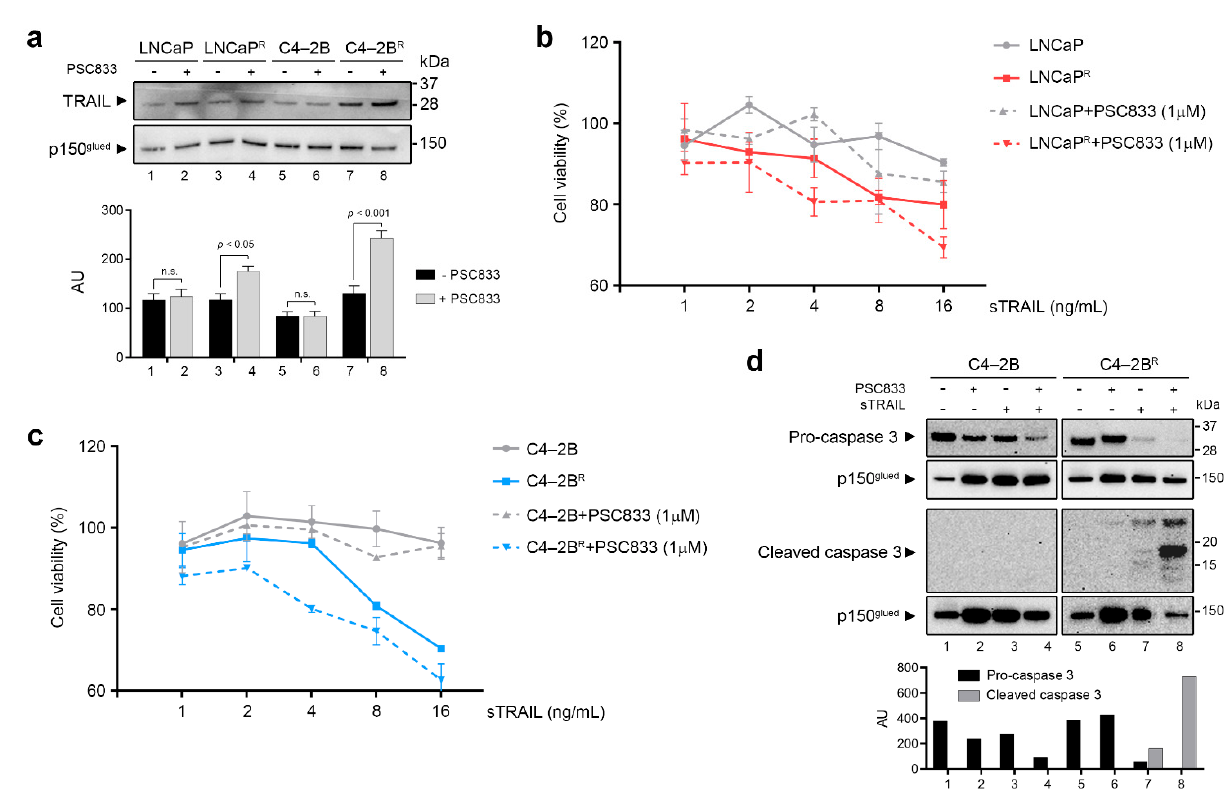
Figure 6. TRAIL status and its role in docetaxel-resistant prostate cancer (PCa) cell lines ( a ) Parental and resistant cells were cultured in the presence or absence of the ABCB1 inhibitor PSC833 for 48 h and total cellular protein extracts were used to assess endogenous TRAIL expression by Western blot. Full Western blot image can be found in Figure S2. Upper panel: representative immunoblot showing levels of TRAIL protein present in whole cell extracts. P150 was used as normalizing control. Lower panel: graphs depicting pooled densitometry measurements of TRAIL levels relative to those of p150 in arbitrary units (AU). Data points are presented as mean ± SEM of triplicate measurements. ( b ) Cell viability was measured using MTT assay and normalized to an untreated control. LNCaP and C4-2B were treated with increasing doses of sTRAIL for 48 h. ( c ) LNCaP R and C4-2B R were treated for 48 h with vehicle, PSC833 alone, sTRAIL alone, or a combination of 1 µ M PSC833 and increasing doses of sTRAIL. ( d ) Procaspase-3 and activated caspase-3 expression was assessed by Western blot after a pretreatment with PSC833 alone, sTRAIL alone, and PSC833 combined with sTRAIL. Lower panel: graphs depicting densitometry measurements of Procaspase-3 and activated caspase-3 levels relative to those of p150 in arbitrary units (AU). Full Western blot image can be found in Figure S3.